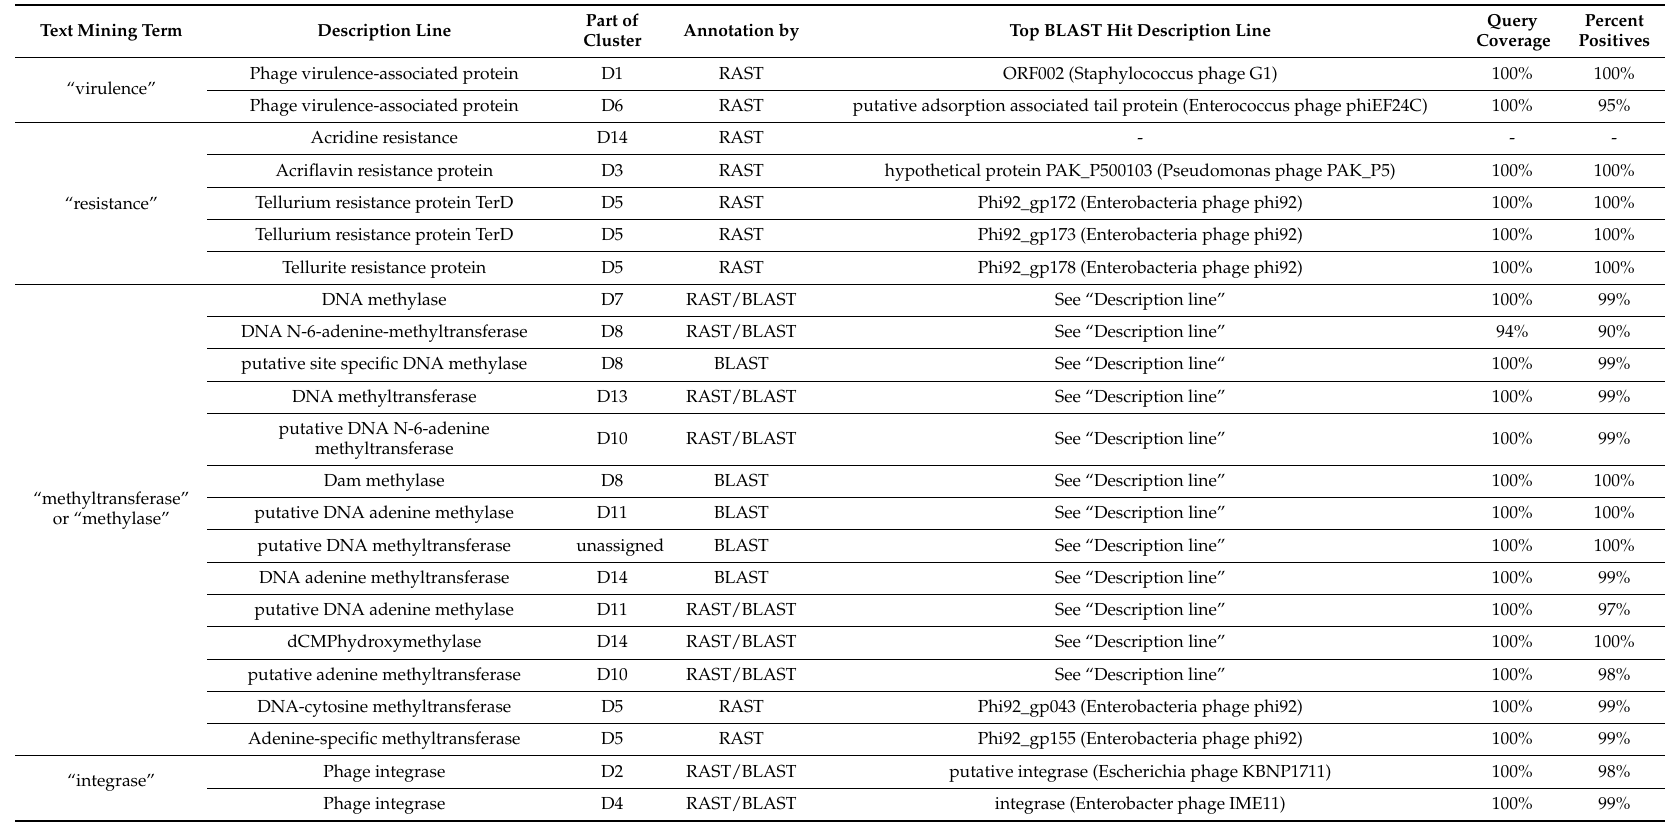
Table 4. List of genes potentially relevant for efficacy, found by text mining annotation results. The annotation column details whether the gene was found in the annotation provided by RAST, by BLAST or both. If only one is named the other method either did not predict the gene or annotated it differently. Top BLAST hit, query coverage as given by BLAST and percent identity as given by BLAST are only filled out if applicable. Most genes which were picked up for their RAST annotation still have a BLAST hit description line, query coverage and percent identity values because that gene was also called by GeneMarkS. In any case, the last two columns apply to the BLAST hit, but not necessarily to the hit in the RAST databases. The acridine resistance gene evidenced in D14 was not called by GeneMarkS. If the gene was picked up for its BLAST annotation column 2 and 5 are